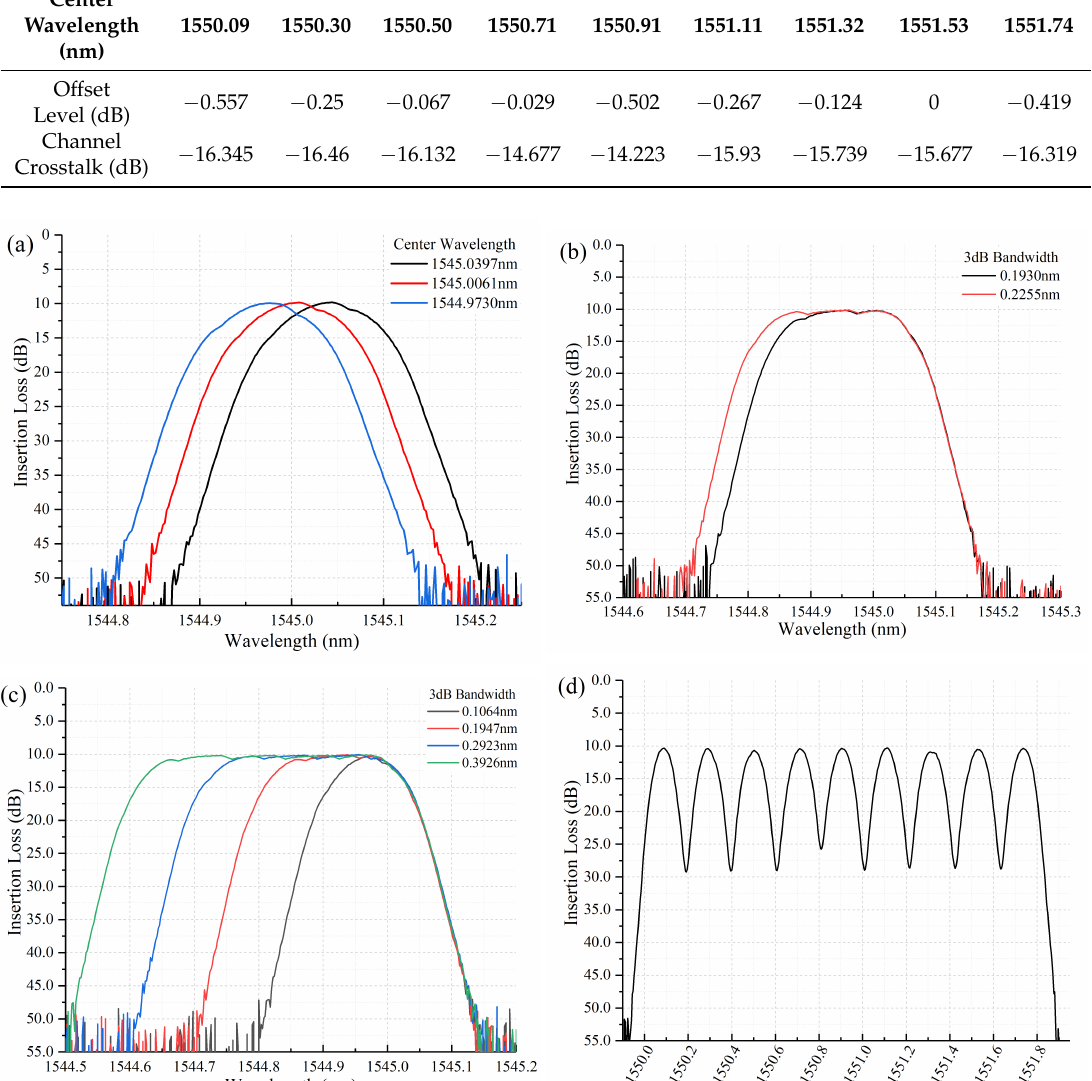
Table 2. Channel crosstalk and offset level at nine grid frequencies ( 25 GHz channel separation).